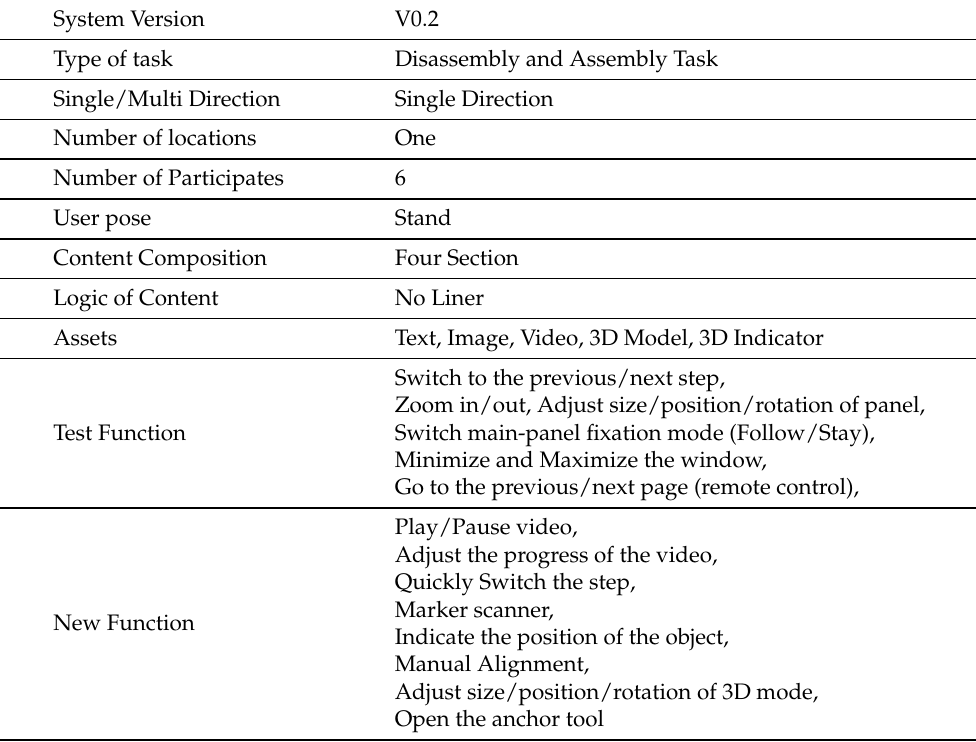
Figure 16. Case No. 2: HDD replacement task. Table 4. The detail of the second case